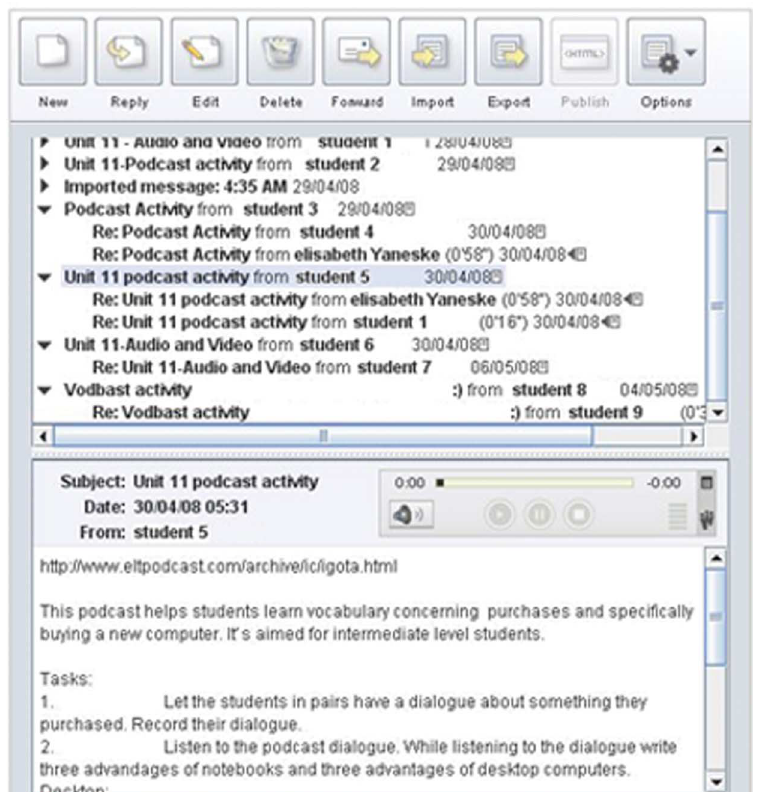
Figure 4. The virtual staffroom